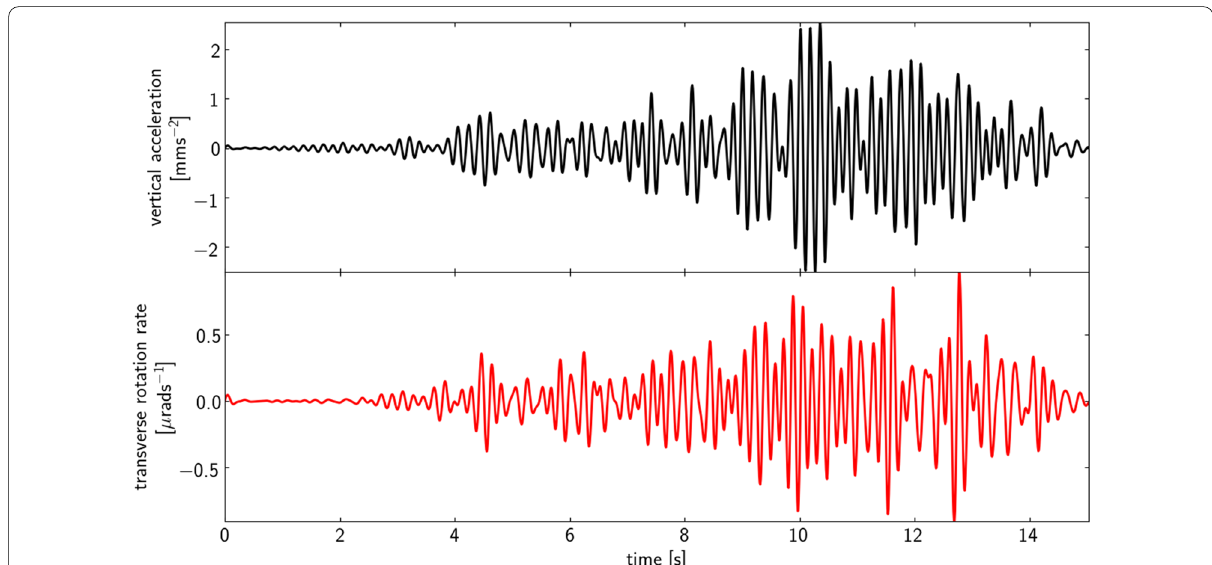
Fig. 4 Active seismic signals on the moon. Translational acceleration signal recorded after the detonation of 454 g of explosive in a distance of 1.2 km from the Apollo17 geophone array (top panel) and the corresponding array‑derived rotation rate (bottom panel), bandpass‑filtered between 3 and 7